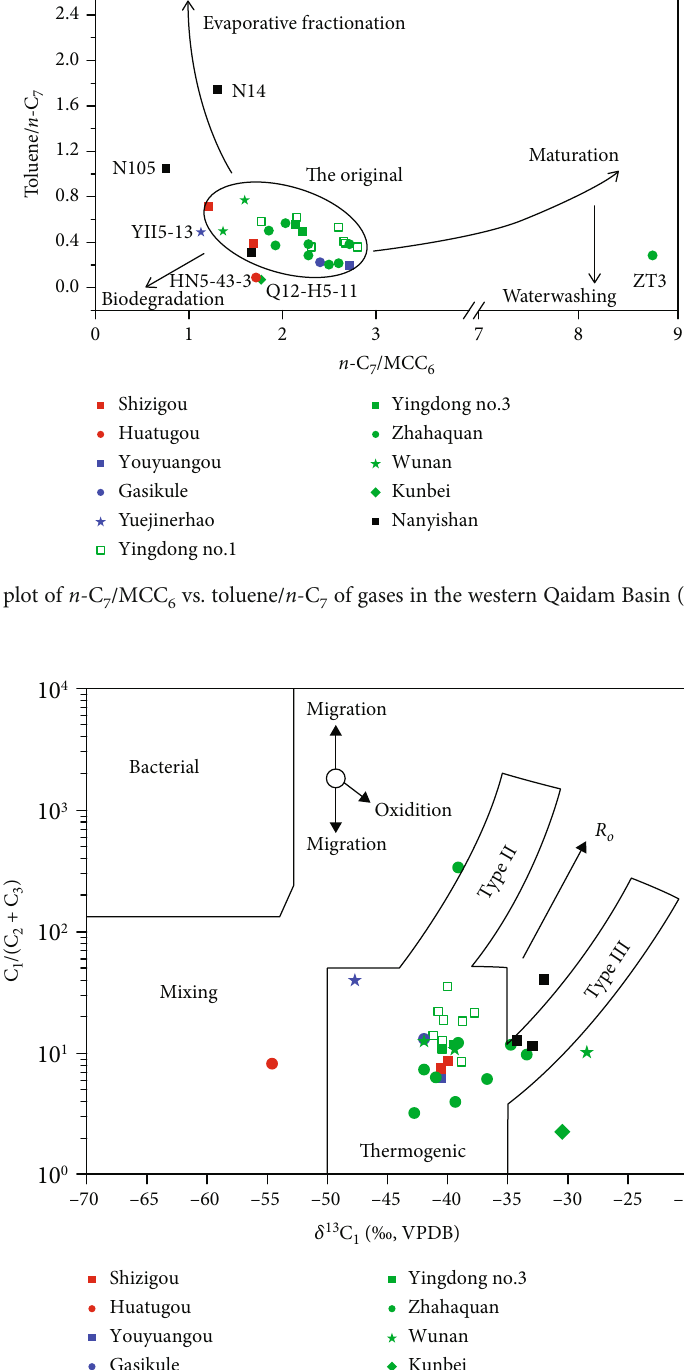
/(C +C ) vs. δ 13 C of gases in the western Qaidam Basin (modi fi ed after [13, 38]). 1 2 3 1